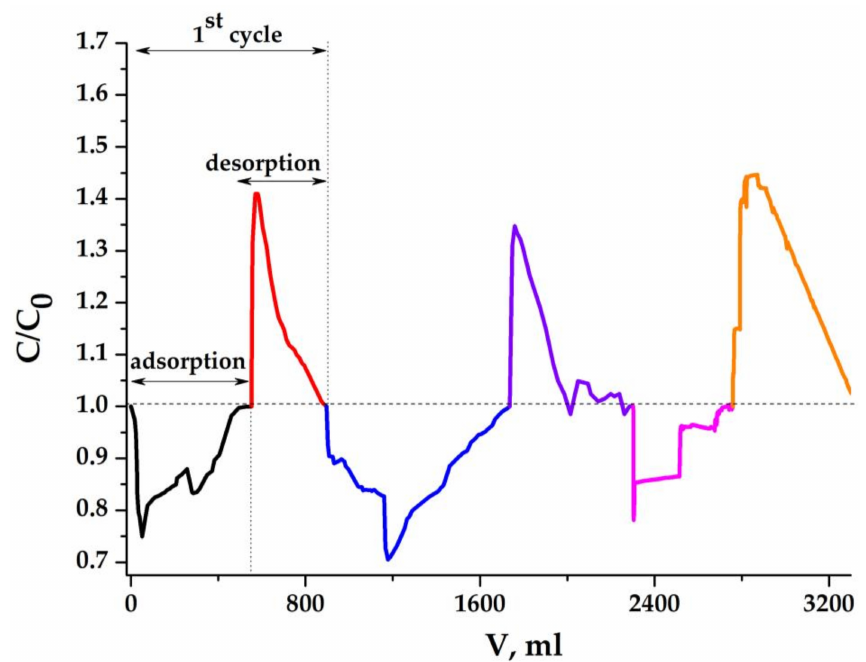
Figure 17. Three successive cycles of MCDI experiments on mesoporous carbon based electrodes C 0 = 1 g / dm 3 ; U = 1.2 V; electrodes (cm): 12 × 3 × 0.2; electrode gap: 0.3 cm; flow rate: 1.15 cm 3 /